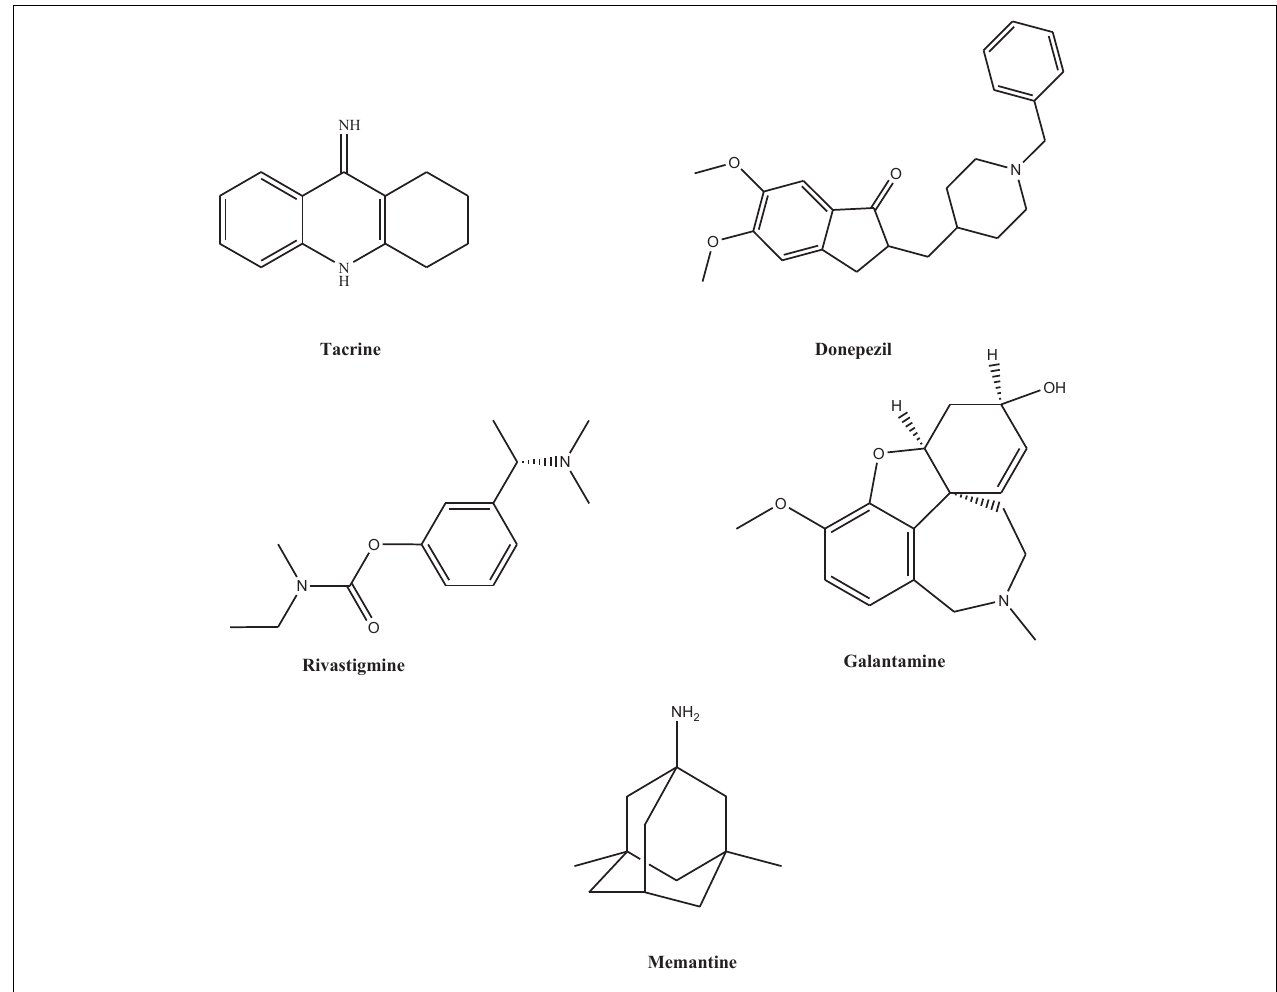
FIGURE 1 | Chemical structures of various therapeutic compounds for the treatment of AD.